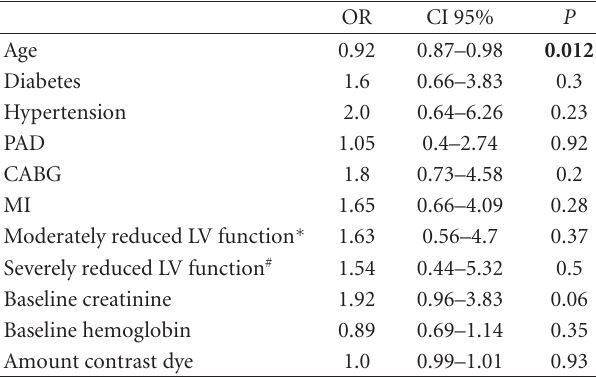
Table 3: Univariate predictors of acute kidney